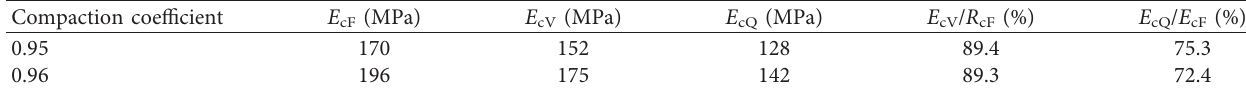
Table 13: Comparison of RM among specimens compacted using VVCM, QSCM, and